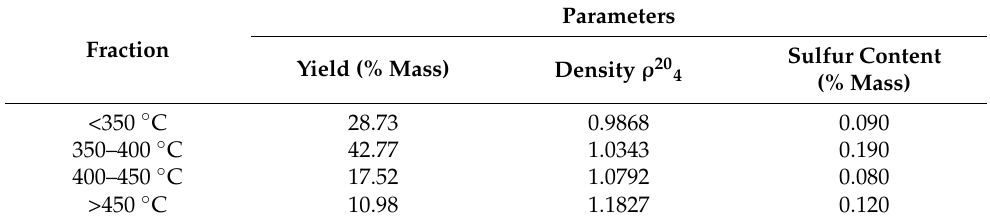
Table 3. Physicochemical properties of the narrow fractions of the original gasoil. Parameters Fraction Yield (%